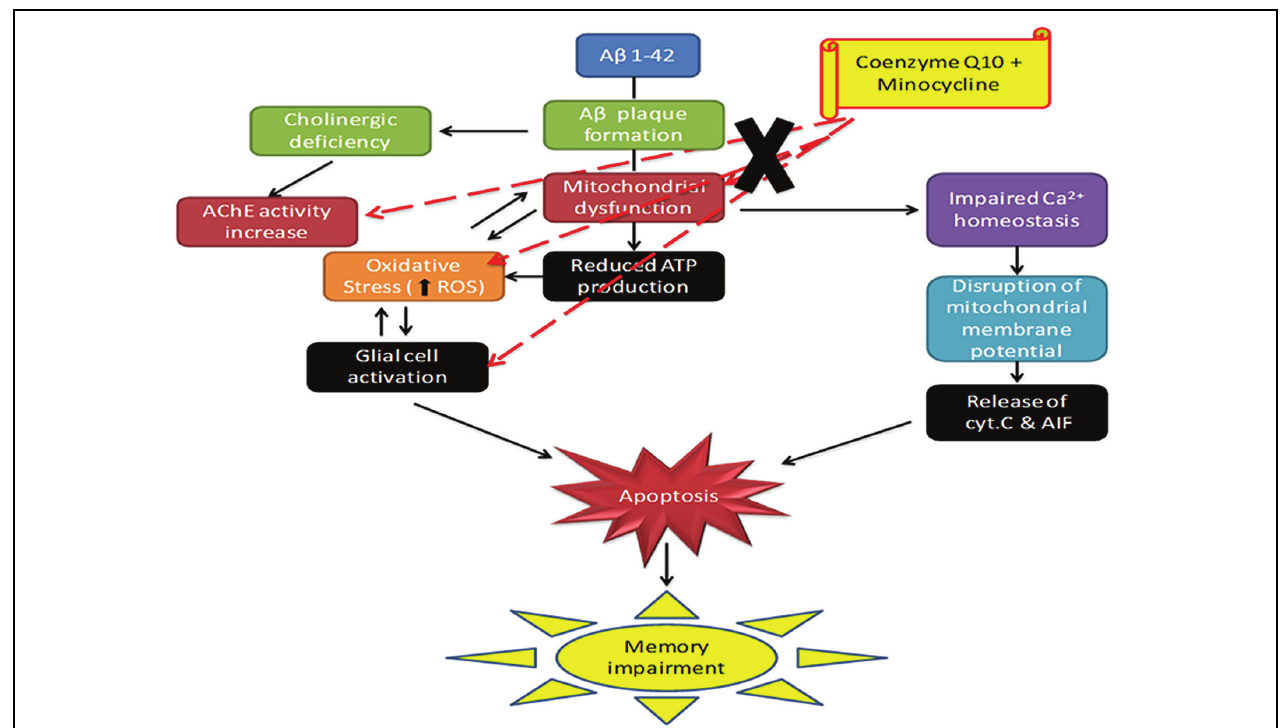
FIGURE 9 | Schematic diagram showing the mechanism of action of CoQ10 and Minocycline (CoQ10, coenzyme Q10; Minocycline, minocycline; AChE, acetylcholinesterase; Cyt. C, cytochrome c).